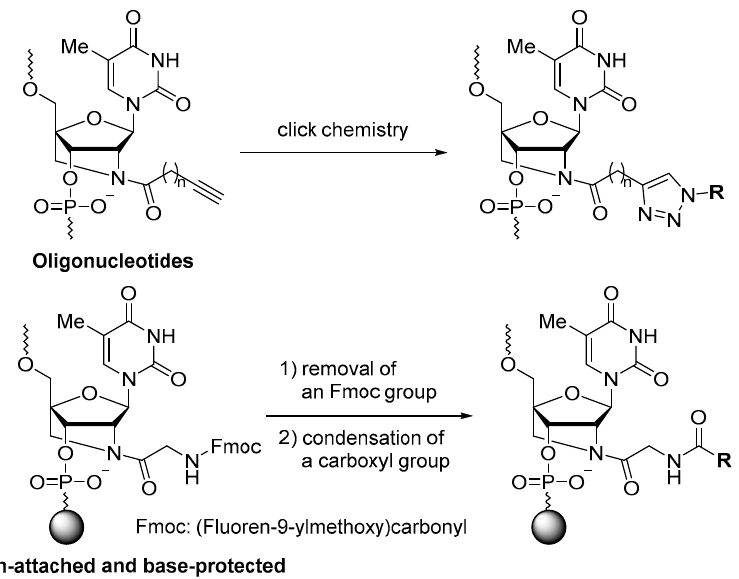
Figure 1. Synthesis of 2 ′ - N -substituted 2 ′ -amino-LNA in oligonucleotides by post-synthetic Synthesis of 2 (cid:48) - N -substituted 2 (cid:48) -amino-LNA in oligonucleotides by post-synthetic modification using click chemistry and amidation. modification using click chemistry and